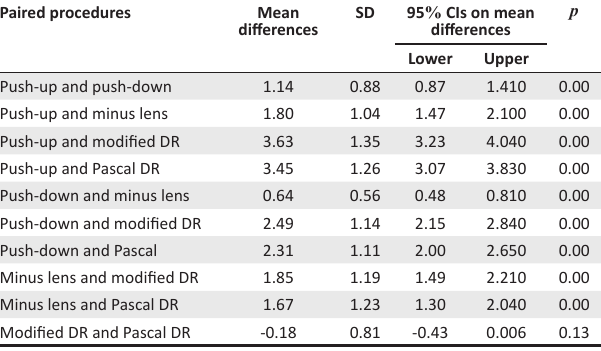
TABLE 2: Comparison of the amplitude of accommodation measurements between five different methods. Paired procedures